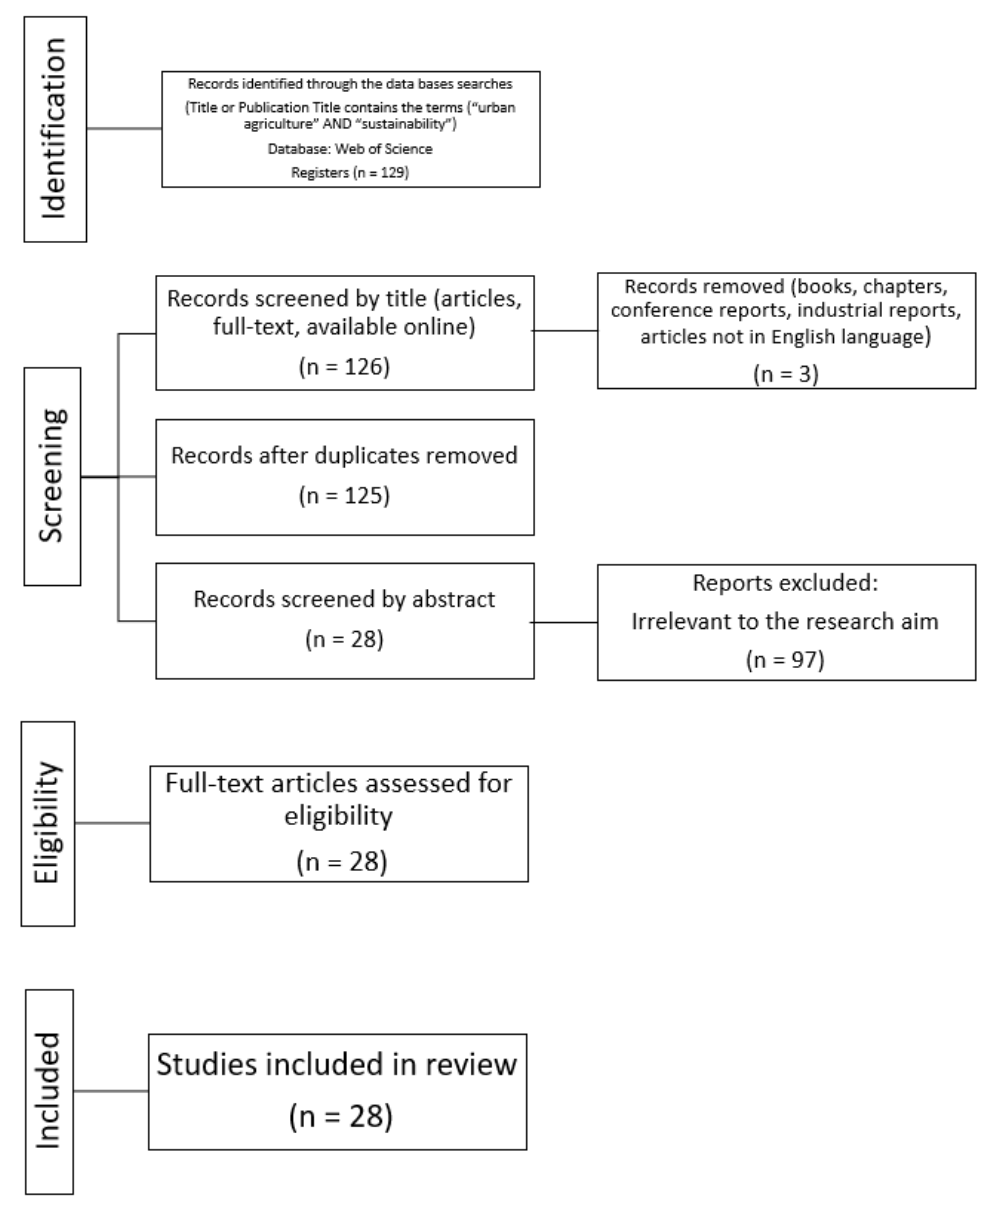
Figure 1. The PRISMA selection process of relevant